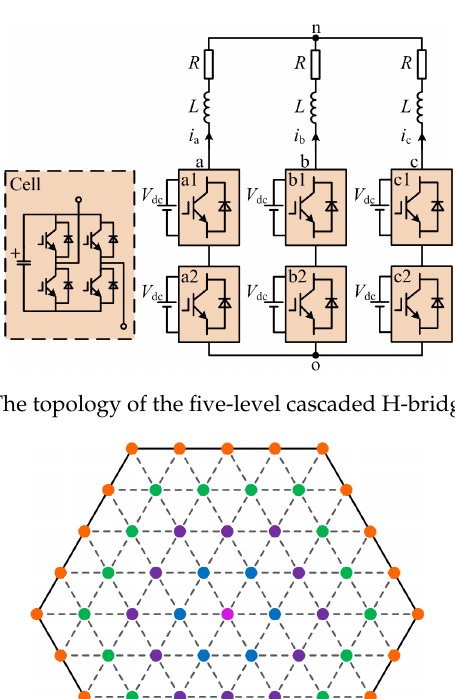
Figure 3. The coordinate components of the voltage space vectors in the a-b-c coordinate system. From Figure 3, it can be seen that the coordinate components of the voltage space vectors are symmetrically distributed in the six sectors. Therefore, in order to simplify the calculation process, the voltage space vectors in other sectors can be normalized to Sector I by interchanging the coordinate components [36]. Figure 4 shows the symmetry of the vector distributions ( θ 1 = θ 2 = θ 3 = θ 4 = θ 5 = θ 6 ). The voltage space vectors in two adjacent sectors are symmetrically distributed with respect to the axis on which the two adjacent sectors coincide. For example, the voltage space vectors in Sectors I and II are symmetrically distributed with respect to the c -axis. Therefore, it is only